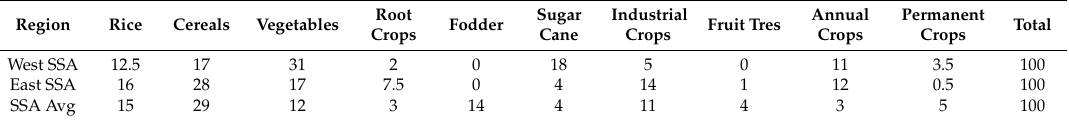
Table 3. Crop type percentage distribution of total irrigated area in the study zone (FAO) [26]. West and East SSA countries are the averages based of the geographical location. SSA Avg: indicates the total average of all of the sub-Saharan African countries. Region Rice Cereals Vegetables